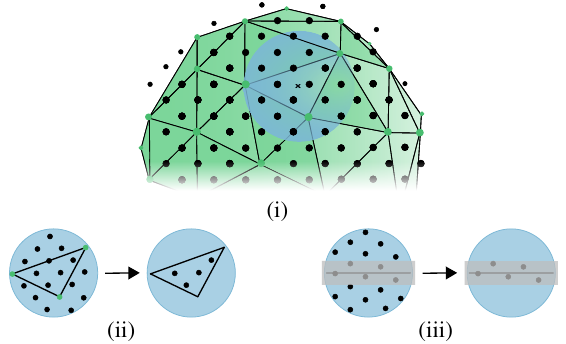
Figure 2. Sequential association steps (i) - (iii) of the PCMA to filter point cloud P for each face 𝑓 : P → P ′ (i) : Clipping of the PC ( black dots ) to the spherical vicinity ( blue ) of the considered face. Its COG is marked with a black cross . The mesh surface and its vertices are depicted in green . (ii) : Filtering of out-of-face points based on the clipping result (orthogonal view concerning the triangular face surface depicted by its edges marked in black ). (iii) : Filtering of off-the-face points (side view with respect to the triangular face). The face is depicted as black line. The threshold band is marked in gray